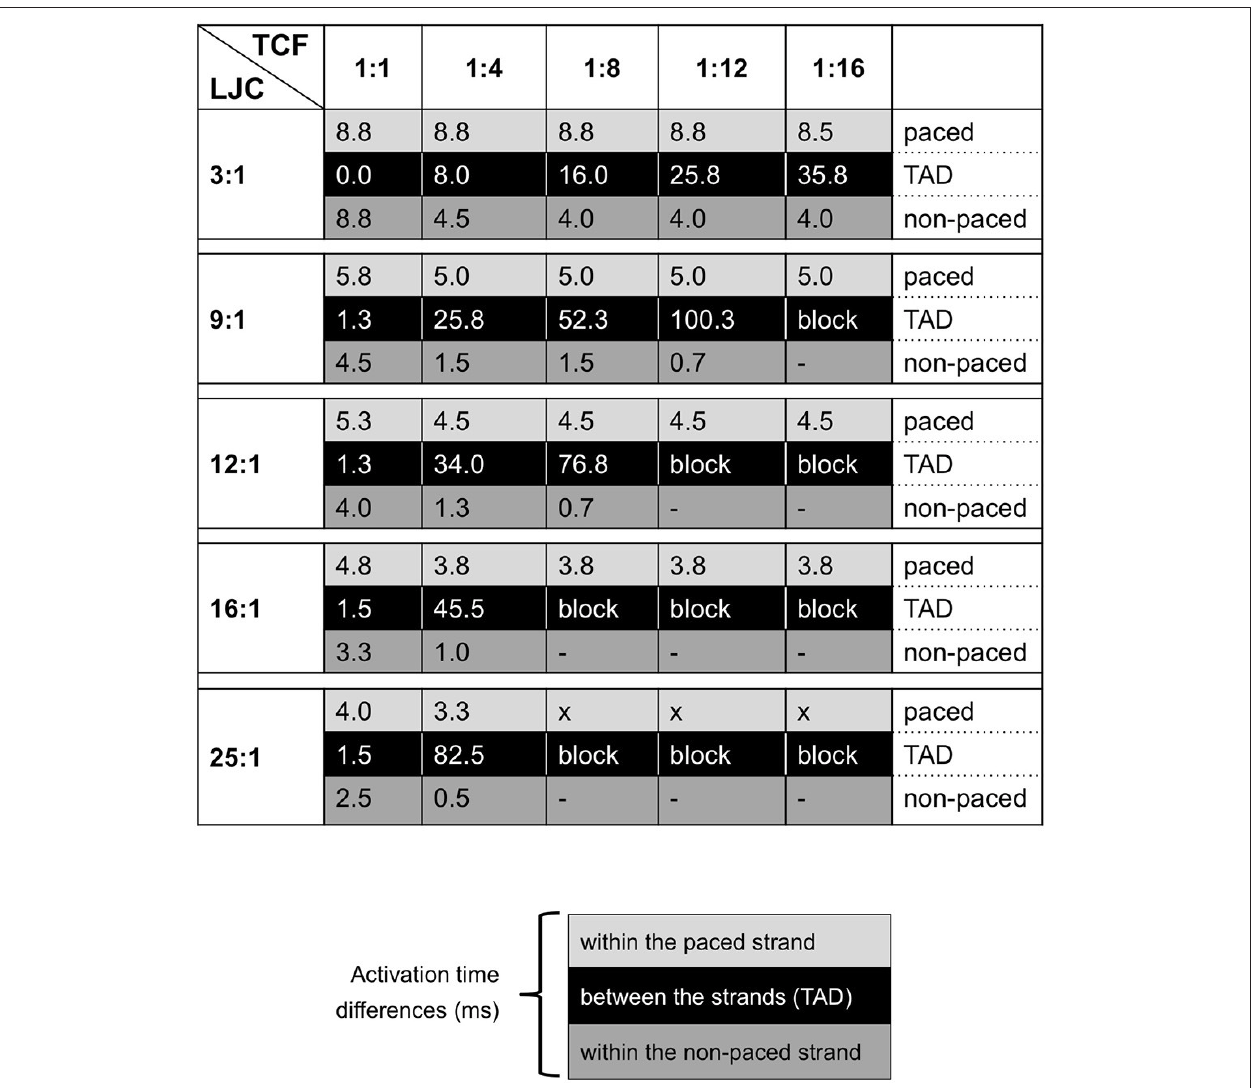
FIGURE 3 | Summarizing table for TAD and activation delays (in milliseconds) in both strands with varied TCF and LJC. Black blocks indicate the TAD; gray and light gray blocks contain entries for activation delays for the non-paced and paced strands, respectively.